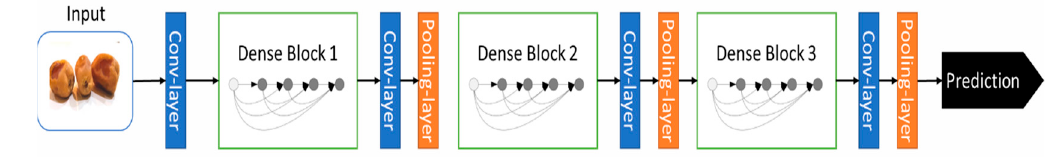
Figure 31. DenseNet-201 prediction model. Table 7. Validation of transfer learning.